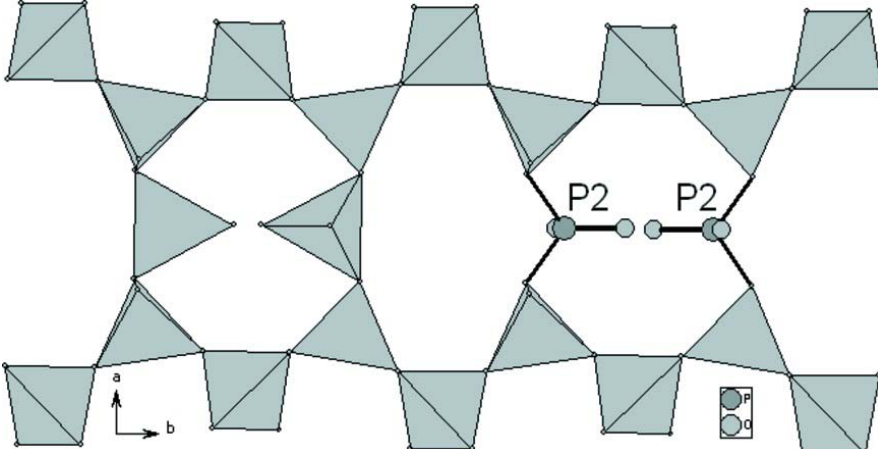
Figure 3 O ) 3- anionic ribbon running parallel to the b axis. (P 5 14 Cerium(III)